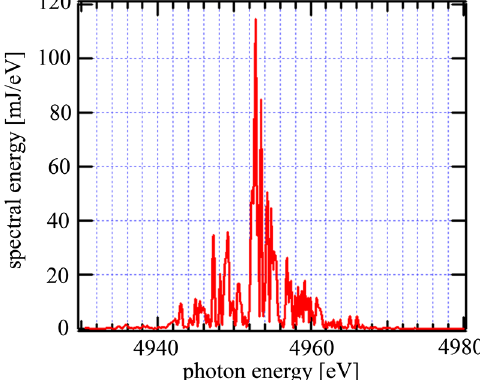
FIG. 4. The spectrum of the FEL pulse that was used for the wavefront propagation simulation.